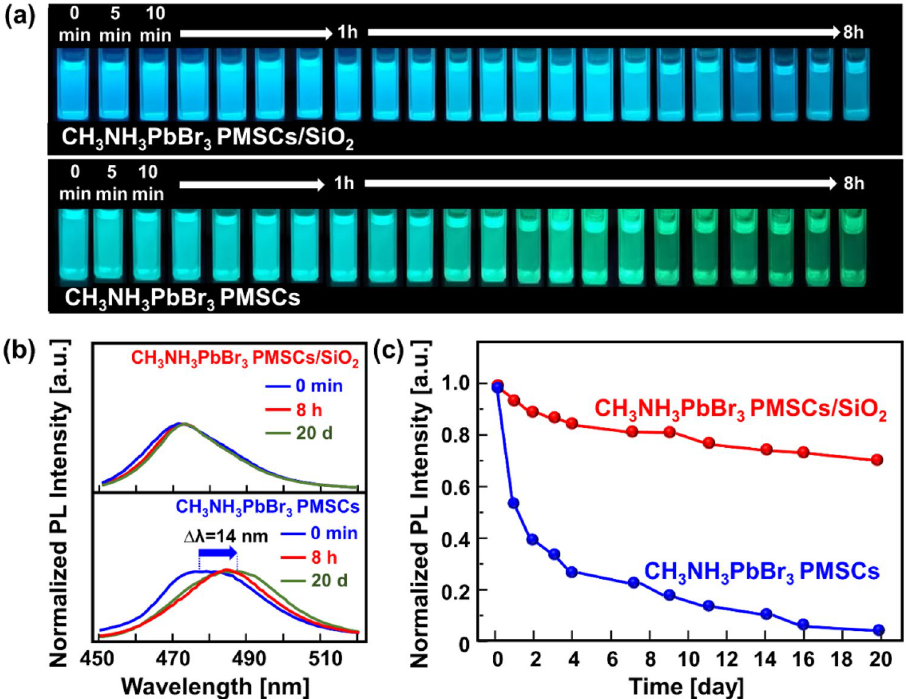
Figure 4. ( a ) Digital photograph of the CH 3 NH 3 PbBr 3 PMSCs and the CH 3 NH 3 PbBr 3 PMSCs/SiO 2 under elapsed-time observation in ambient condition for 8 h. ( b ) The emission PL spectra of the representative samples. ( c ) PL intensity of the samples that observed in ambient condition for 20